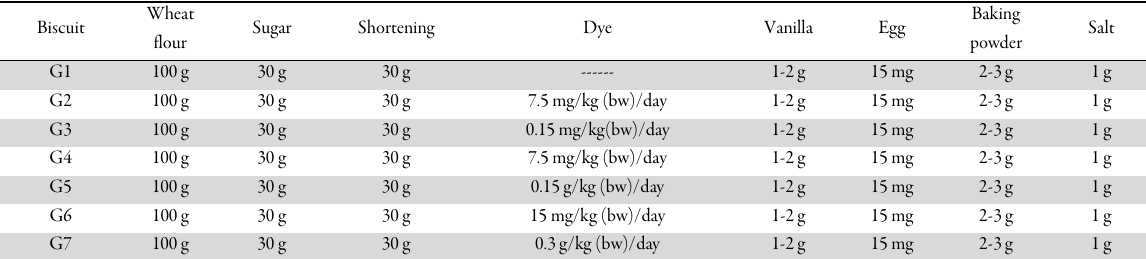
Table 1. Formulation of wheat flour biscuit with different levels of colorants